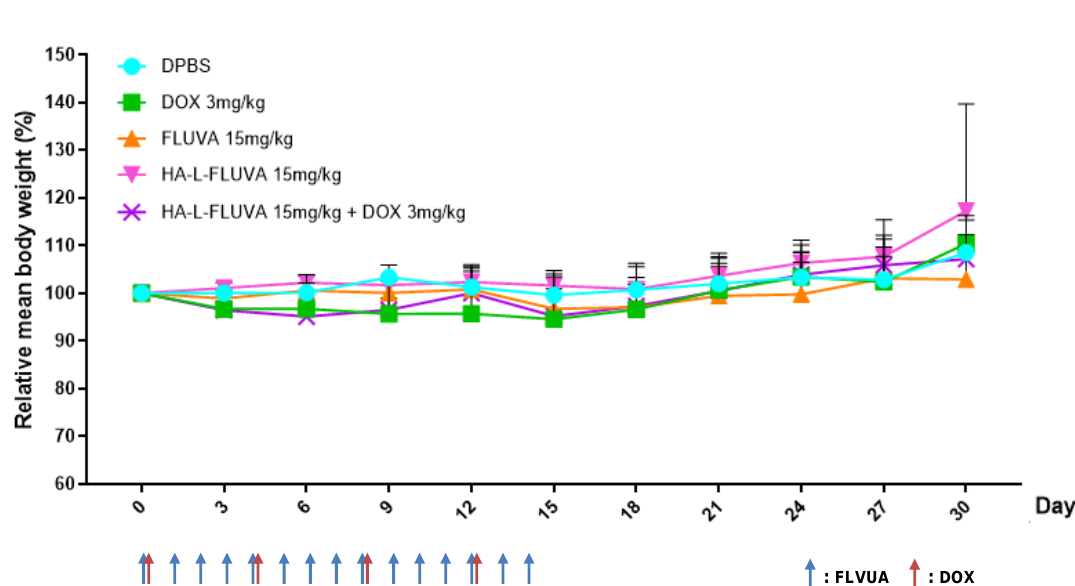
Figure 6. Normalized body weight changes in a xenograft mouse model after a retro-orbital injection of DPBS, DOX, FLUVA, HA-L-FLUVA, and HA-L-FLUVA +